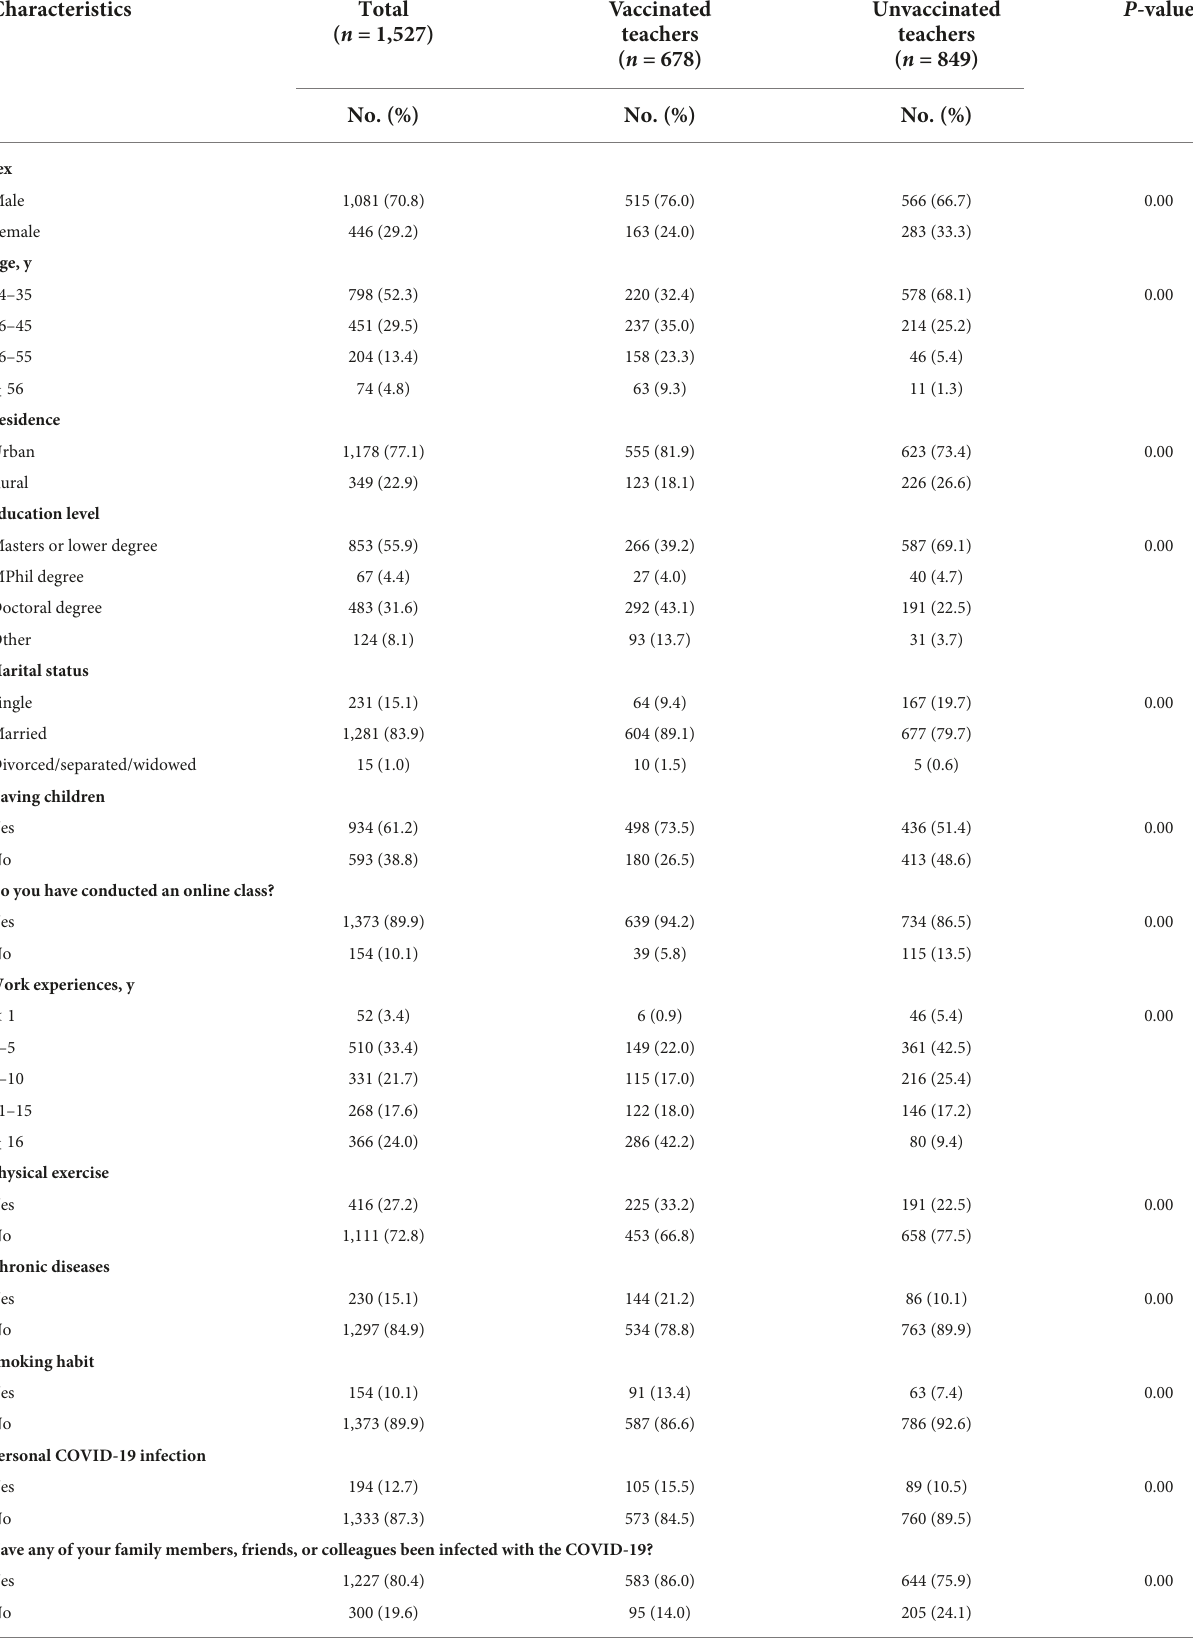
TABLE 1 Demographic characteristics in vaccinated and unvaccinated teachers against COVID-19 infection.